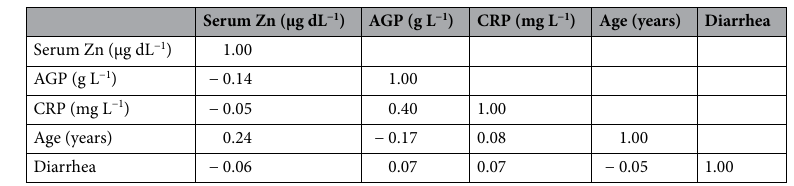
Environmental Systems Research Institute, Redlands. (2011).